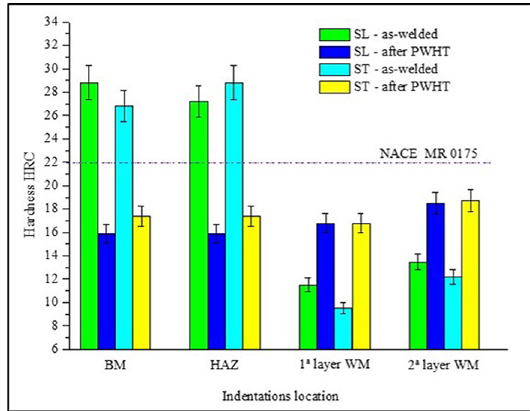
the liquid which may have a temperature lower than the solid phase, together with the convection of the melt pool, can promote penetration and solidification of the